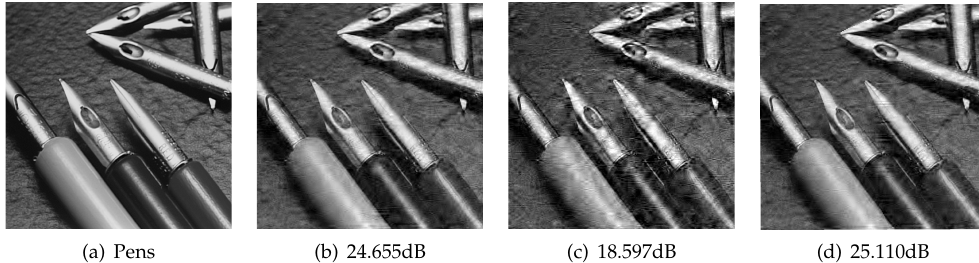
Figure 11. The reconstruction results of the standard test image Pens at τ = 0.4. ( a ) original image; ( b ) reconstructed by HTP with α ∗ = 5, (PSNR: 24.655 dB); ( c ) reconstructed by CGIHT (PSNR: 18.597 dB); ( d ) reconstructed by CGHTP (PSNR: 25.110